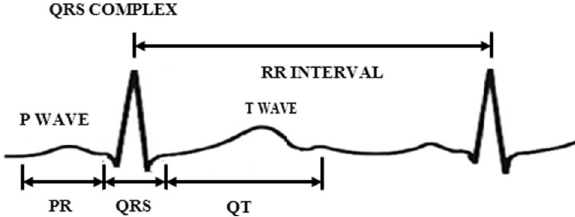
Figure 1. QRS complex waveform.